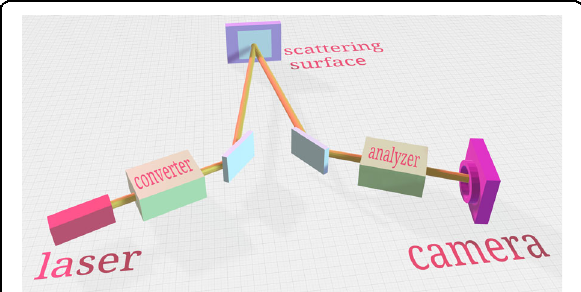
Fig. 1 The experimental setup. Optical pulses from a laser are sent through a phase Converter, which creates the initial time-bin states, while the multimode Analyzer measures the signals scattered off the target (regular white paper). A single-photon-detector-array is used as the detection device, with 8 × 8 individual pixels which are time- tagged separately. During the initial alignment, the incident angle = re fl ected angle =